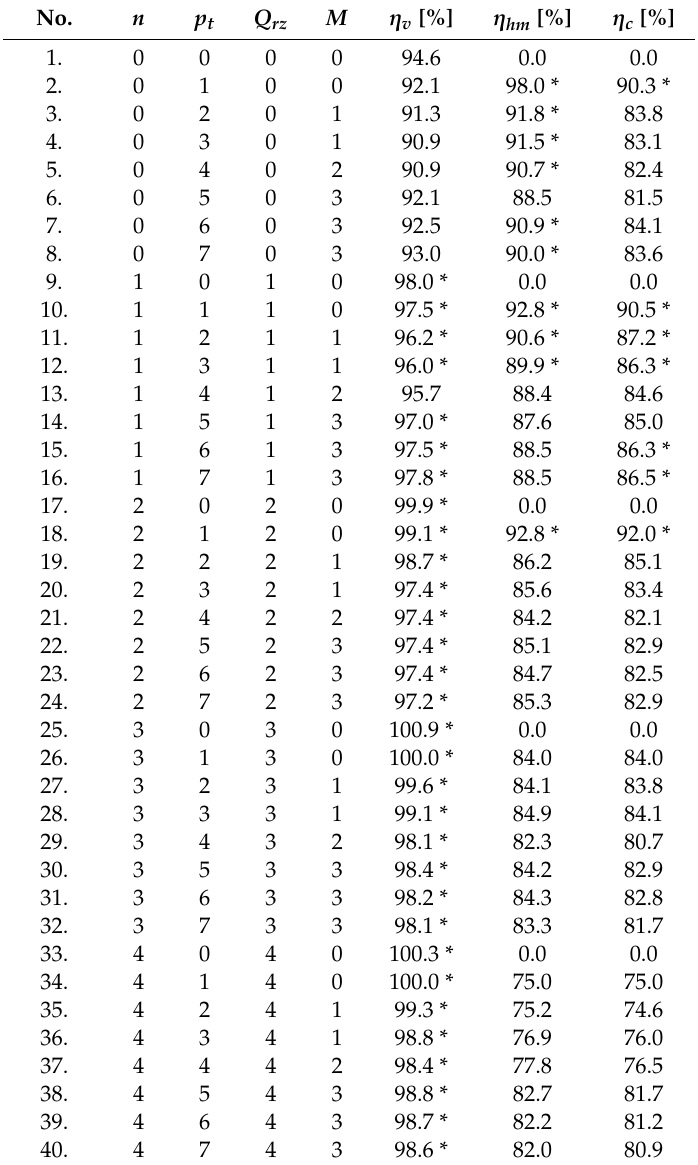
Table 1. Arithmetic and logical values of the established structural and / or operational parameters and target functions [5]. * Numerical values of the individual e ffi ciency changes were adopted as follows: η ≥ 0.96; η ≥ 0.89; η ≥ v c hm